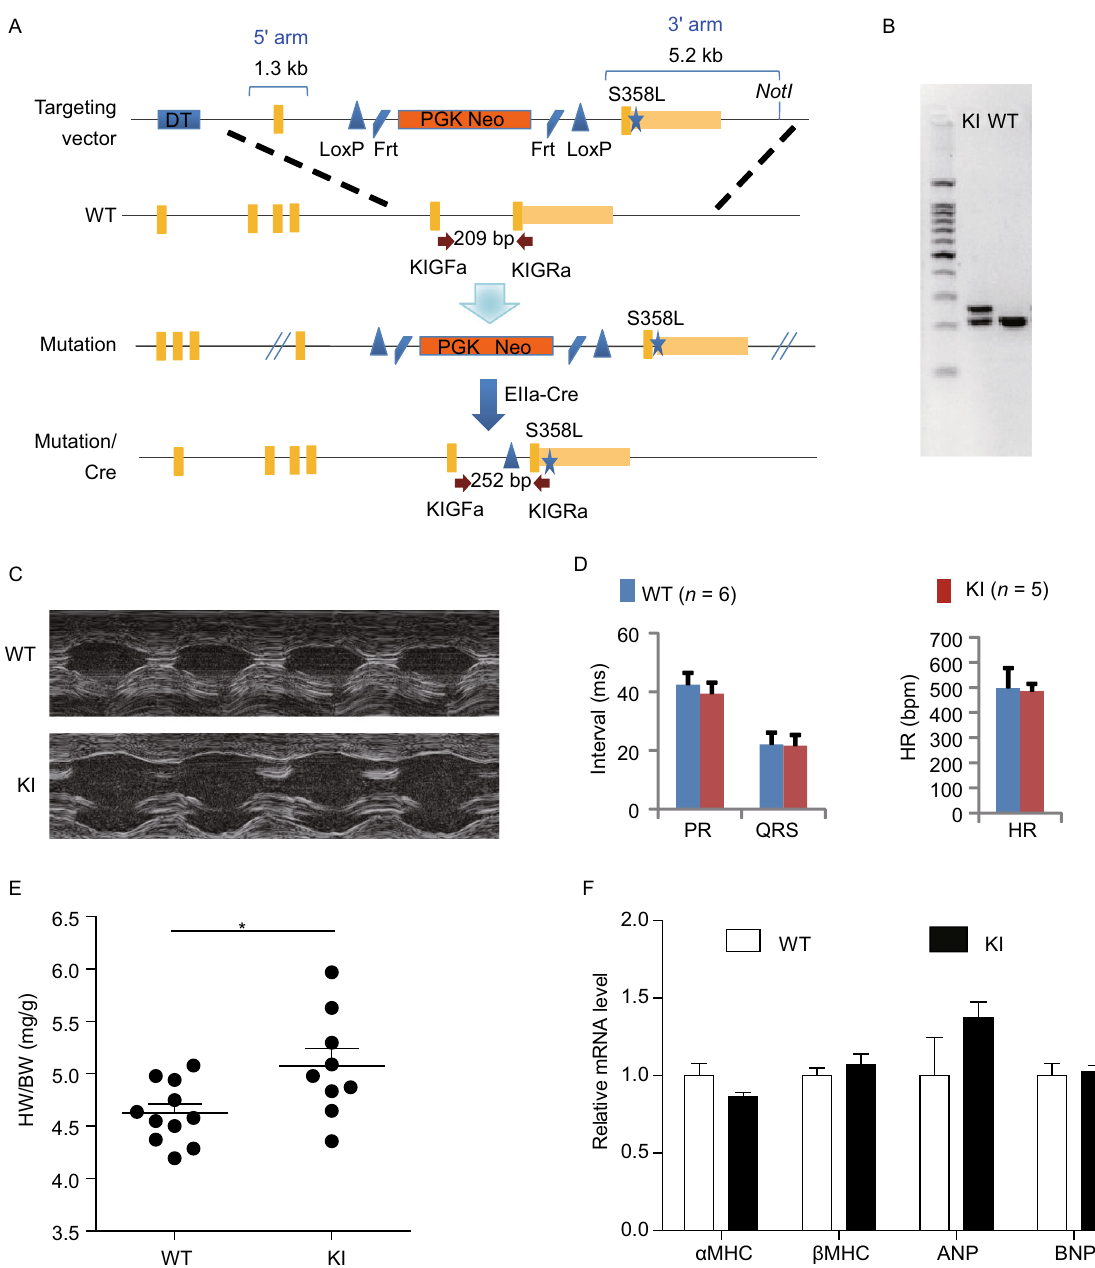
Figure 1. Generation and characterization of ARVD TMEM43 mutation mice. (A) The strategy of the construction of TMEM43 S358L mutation mouse. DT gene provided negative selection, while Neo gene provided positive selection of homo-recombination ES clones. Targeting vector carrying S358L point mutation was homo-recombinated with wild type genome through 1.3 kb 5 ′ arm and 5.2 kb 3 ′ arm. The obtained mutation mice were mated with whole body expression EII α -Cre mice to remove the Neo selection cassette in the intron of Tmem43 gene. (B) Genotyping of TMEM43 S358L knockin (KI) heterozygous mice had a 252 bp and 209 bp PCR product with primer sets of KIGFa and KIGRa, while wild type (WT) mice only had 209 bp product. DNA sequencing of the 252 bp PCR products veri fi ed the genomic mutation. (C) The represented fi gures in ultrasound analysis of littermate WT and TMEM43 mutation KI mice, indicating enlarged heart chambers in KI mice. (D) Electrocardiograph of littermate WT ( n = 6) and KI ( n = 5) mice. The heart rate (HR), PR interval and QRS interval were compared between the groups of WTand KI mice. Student ’ s t -test was used for statics analysis. (E) The heart weights and body weights of 8-week old male WT ( n = 11) and KI ( n = 9) mice were detected and the ratios of heart weights verse body weights were calculated. (F) Quantity PCR assay showed the mRNA level of the markers of cardiac hypertrophy in the hearts of WT ( n = 5) and KI ( n = 7) mice. Student ’ s t -test was used for statics